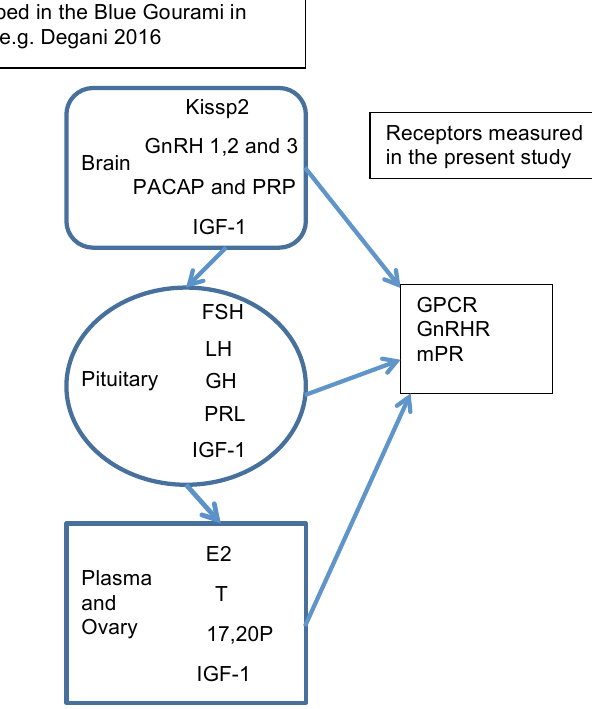
Figure 4. BPG axis hormones involved in regulating oogenesis in Anabantidae fish, as previously described in blue gourami, e.g., [1] and receptors measured in the present study In the brain: Kisspeptin 2-Kissp2, GnRH-gonadotropin-releasing hormones, pituitary adenylate cyclase-activating polypeptide (PACAP), and its related peptide (PRP) insulin-like growth factor-1 (IGF-1). In the pituitary: Follicle-stimulating hormone (FSH), luteinizing hormone (LH), growth hormone (GH), Prolactin (PRL). In the plasma and ovary: 17 β -estradiol (E2), testosterone (T), 17 α ,20 β -dihydroxy-4-pregnen-3-one